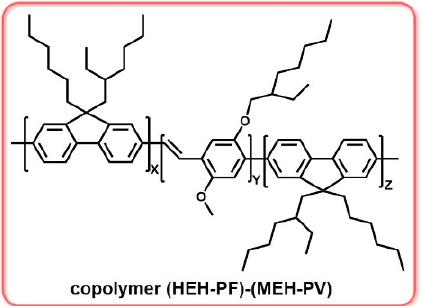
Figure 11. The chemical structure of copolymers of PF and PPV: poly(9,9-methylhexyl-hexyl) fluorene (HEH-PF) and 2-methoxy-5-(2′-ethyl-hexyloxy)- p -phenylenevinylene (MEH-PPV).